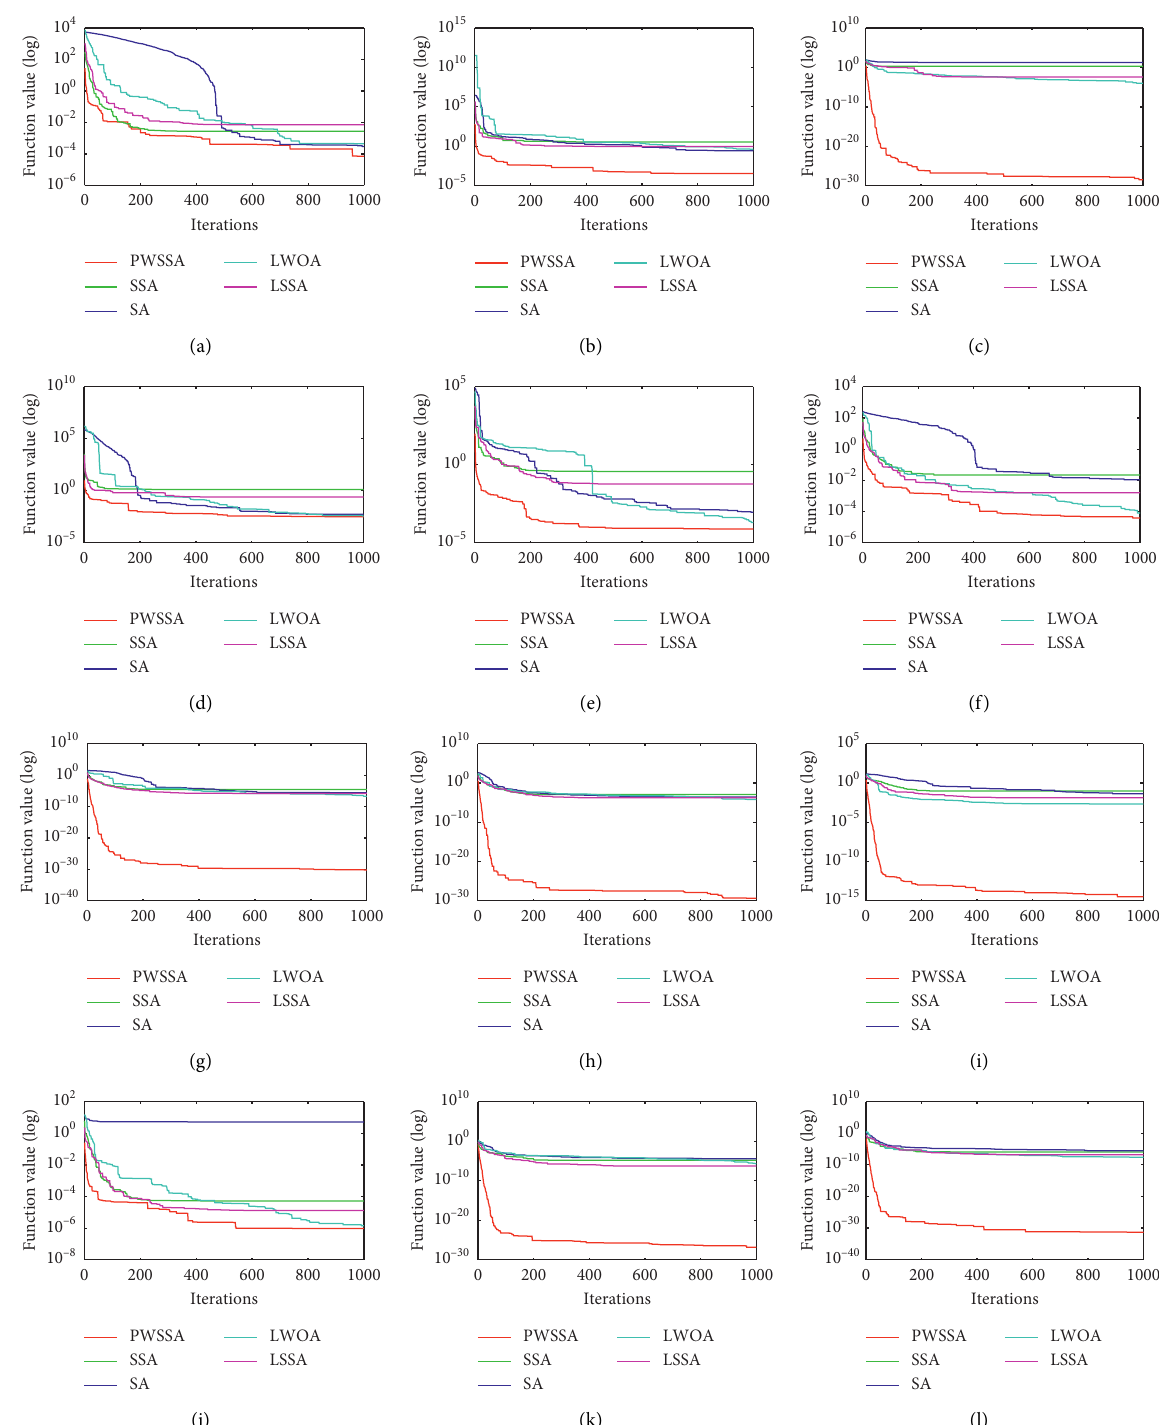
Figure 2: Convergence curves for functions ( D � 2). (a) f f 12( D � 2)